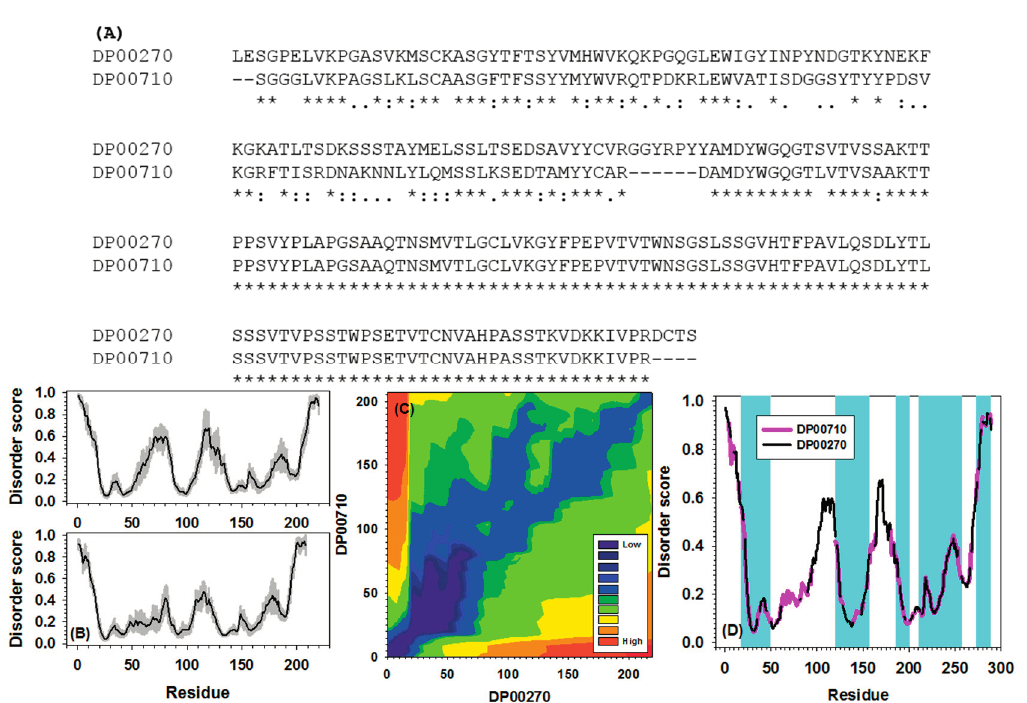
Figure 5. Identified alignment path for a sequence pair (Disprot IDs: DP00270